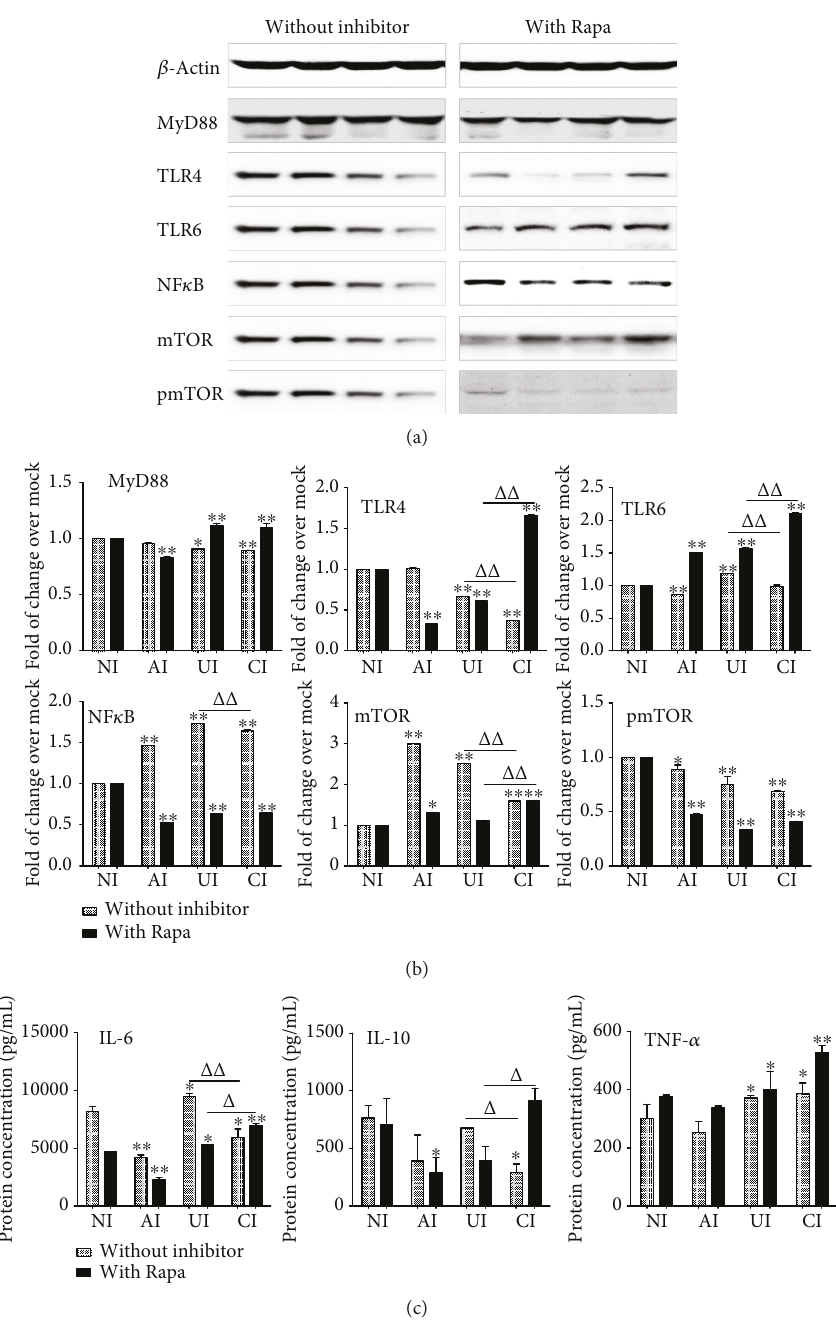
Figure 9: Impact of mTOR on the expression of TLR ligands and elements of the TLR signaling pathway in U937 cells to H37Rv infection in the A549 cell coculture model. In the presence or absence of mTOR inhibitor rapamycin, the coculture model of A549/U937 cells was infected with H37Rv mycobacteria from the upper chamber (A549 cells, AI), lower chamber (U937 cells, UI), or both chambers (A549 and U937 cells, CI) at a MOI of 3 for 18h before the culture medium and U937 cells were harvested for analysis. (a) Representative blots of immunoblotting assay for indicated components of TLR signaling cascade showed an increased expression of TLRs and MyD88 but a reduced expression of NF- κ B in U937 cells of the coinfection model in the presence of rapamycin, in comparison with the absence of an inhibitor. (b) The fold of changes of proteins of interest in (a) semiquantitatively determined by densitometric assay using ImageJ software from three independent experiments. (c) Concentrations of TNF- α , IL-10, and IL-6 in culture media determined by ELISA. An increased TNF- α was observed in the presence of mTOR inhibitor rapamycin. The A549 cell-mediated reduction of cytokines in the Mtb H37Rv-infected U937 cells was reversed in the presence of mTOR inhibitor rapamycin. Error bars represent the standard deviation (SD) from three independent experiments. Compared to noninfection (NI) control, ∗ p < 0 05 and ∗∗ p < 0 01 ; compared to the absence of LiCl, Δ p < 0 05 and ΔΔ p < 0 01 . NI: noninfected control; AI: infection was performed on A549 cell alone; UI: infection was performed on U937 alone; CI: infection was performed on both A549 cells and U937